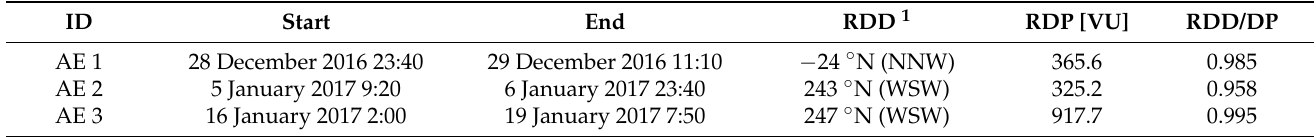
Figure 11. Wind climate for the period 21 December 2016–20 January 2017: ( a ) the wind rose based on wind blowing directions; ( b ) the sand rose calculated considering the wind climate and sediment grain size. Table 1. Results of the aeolian transport potential for the identified aeolian